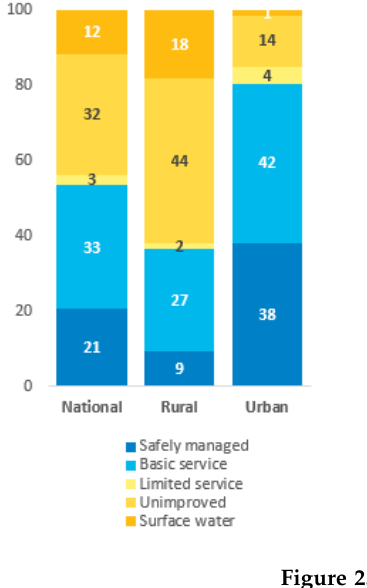
Figure 2. Joint Monitoring Programme for Water Supply, Sanitation, and Hygiene (Data source: WHO/UNICEF JMP 2021, https://washdata.org/ (accessed on 26 September